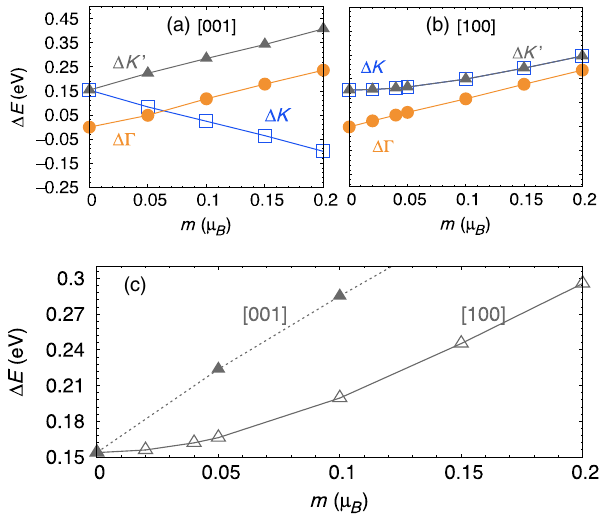
FIG. 5. Splitting at Γ (circle), K (square), and K 0 (triangle) obtained with noncollinear calculations as a function of the magnetic moment on Nb for magnetic moments (a) parallel to the c axis, h 001 i , and (b) perpendicular to the c axis, h 100 i , for monolayer NbSe 2 . The magnitude of the splitting for magnetic moments along h 010 i are similar to the results along h 100 i illustrated in (b). The solid line in (a) and (b) for each plot serves as a guide to the eye. (c) Splitting at K 0 for magnetic moments on Nb parallel to the c axis ([001], dotted line) illustrating the linear dependence on m and magnetic moments perpendicular to the c axis ([100], solid line) illustrating the quadratic dependence on m . The results are the same at K if one considers the magnitude of the change in Δ E versus m